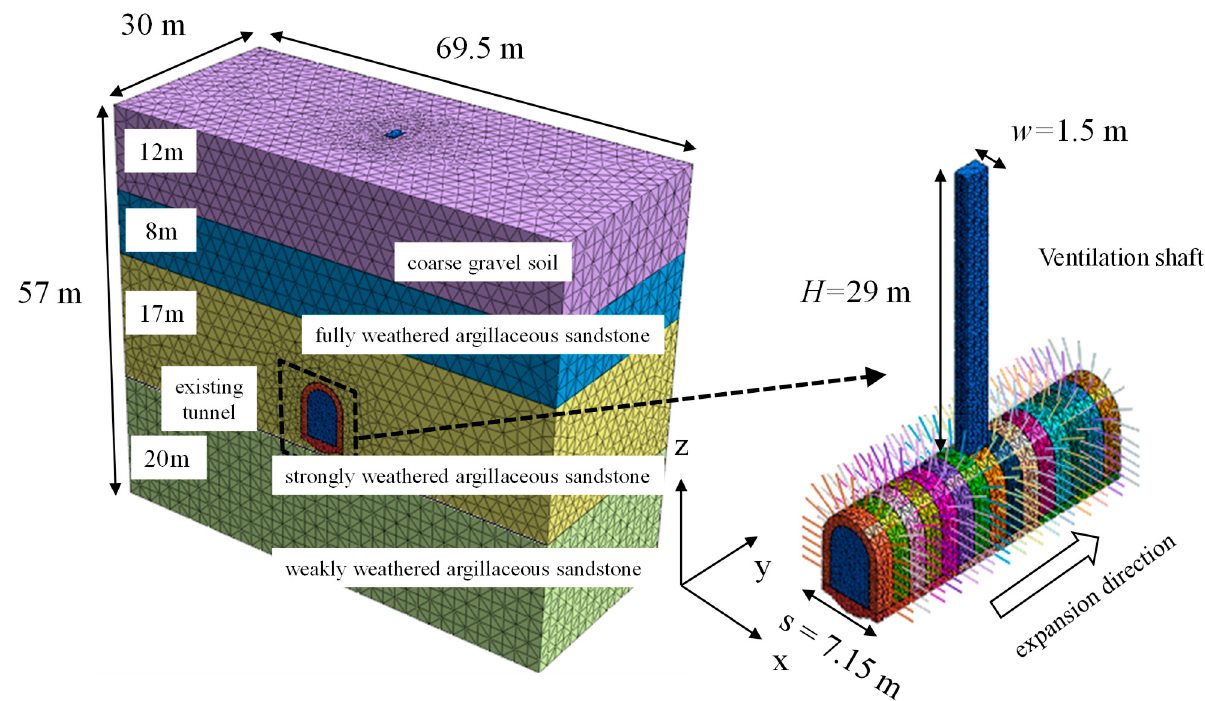
Figure 8. Calculation